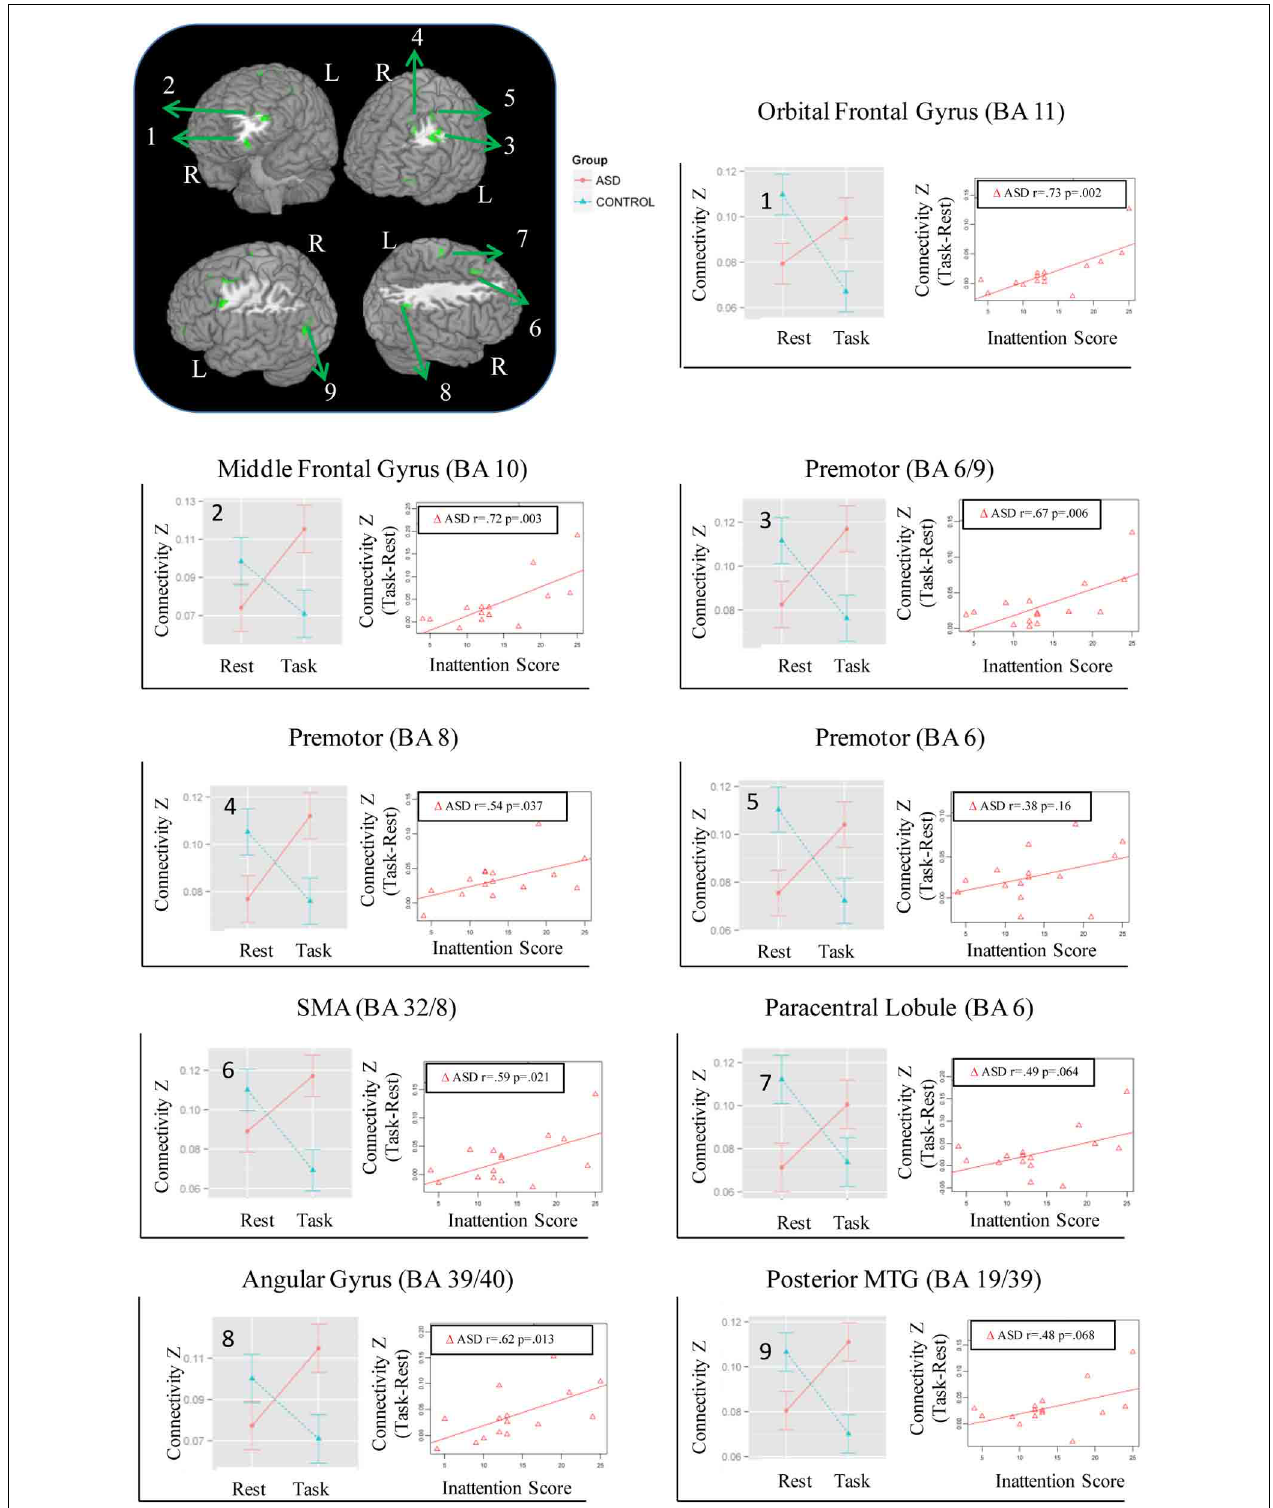
FIGURE 1 | Regions showing Group × State interaction for distant connectivity. Each region is identified with a number on the brain image in the top left corner. The corresponding graphs showing the interaction and correlation with inattention scores in the ASD group are identified with the same number.